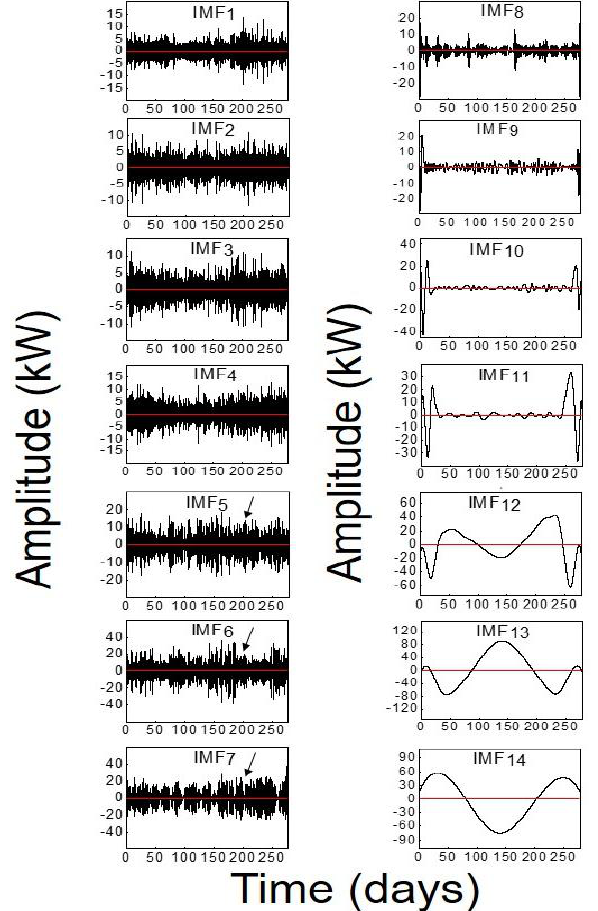
Figure 4. Amplitude of the 14 IMFs as a function of time related to the P 3 active power. An arrow indicates the amplitudes of the IMFs having frequencies close to the ones of the harmonics obtained via the FFT analysis (see the text for a discussion).